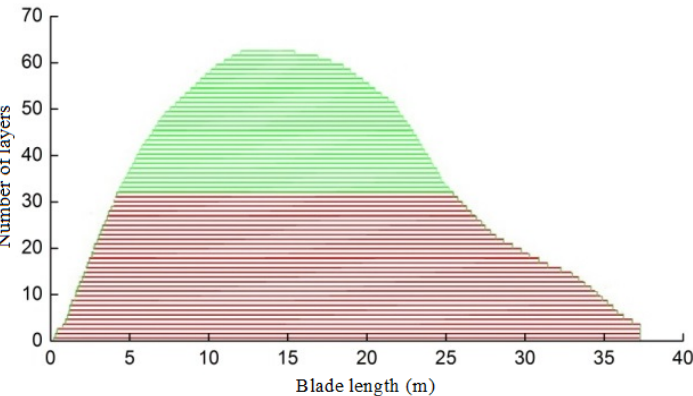
Figure 9. Original material layup of the spar cap.